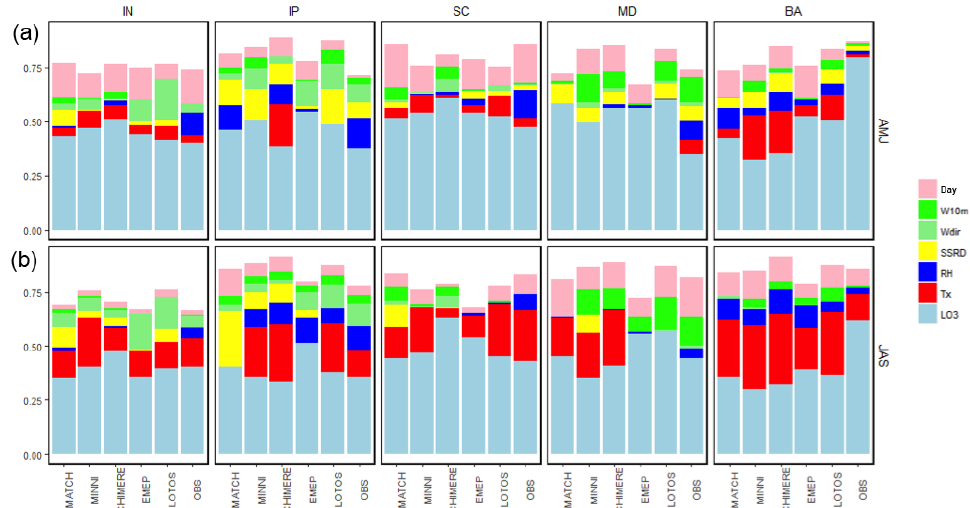
Figure 7. Proportion of each predictor to the total explained variance for each CTM-based (ordered as in Fig. 3) and observation-based MLR in AMJ (a) and JAS (b) for the external regions: Inflow (IN), Iberian Peninsula (IP), Scandinavia (SC), Mediterranean (MD) and Balkans